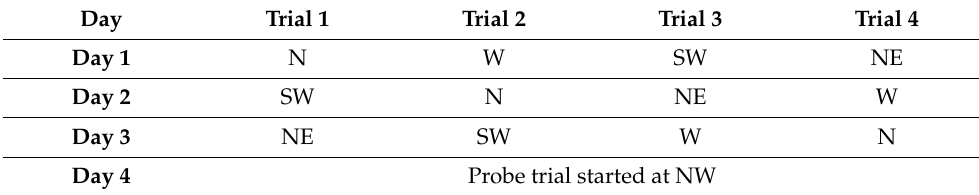
Probe trial started at